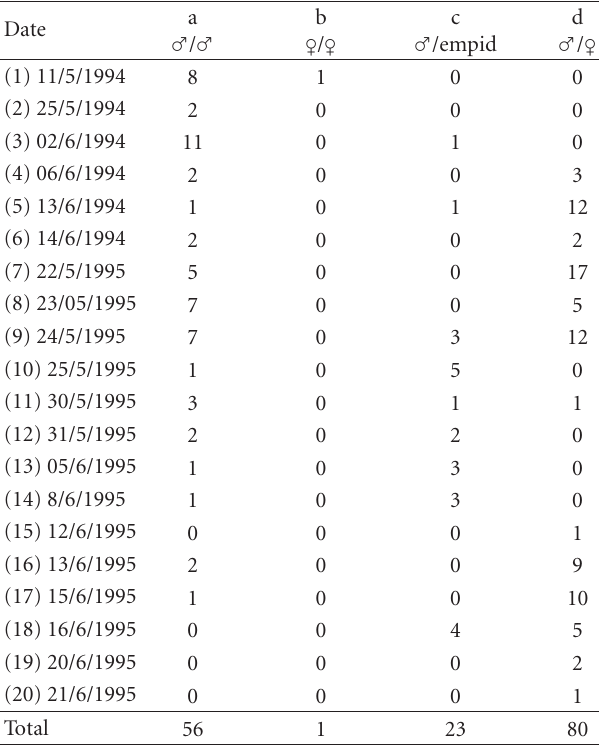
Table 1: Number of pairs, in various categories, captured from mating swarms of the midge Chironomus plumosus , on twenty evenings during 1994 and 1995. The first column assigns code numbers to the occasions. a, male/male pairs. b, female/female pairs. c, male/empid pairs. d, male/female pairs. From primary data of McLachlan [19].